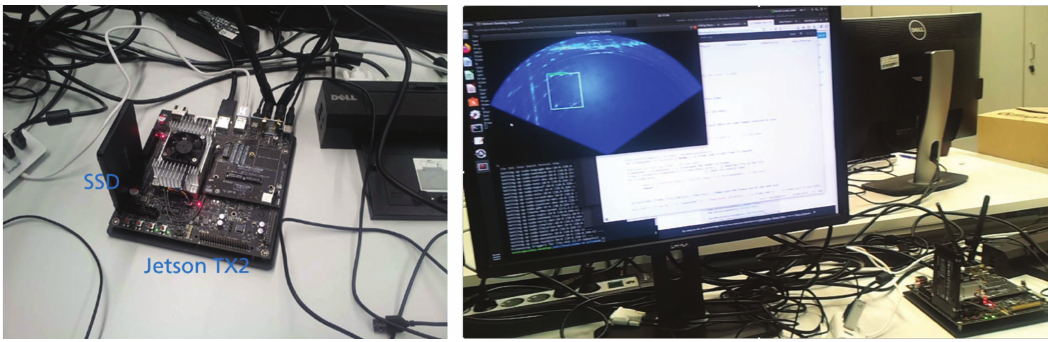
Figure 15. Setup of the object detector in NVIDIA Jetson Board